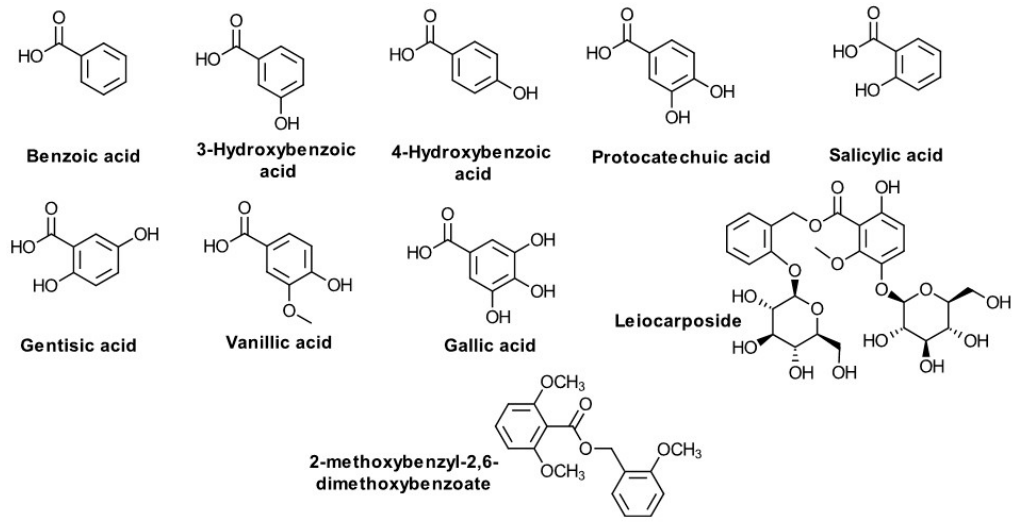
Figure 4. C6-C1 compounds from S. virgaurea L.